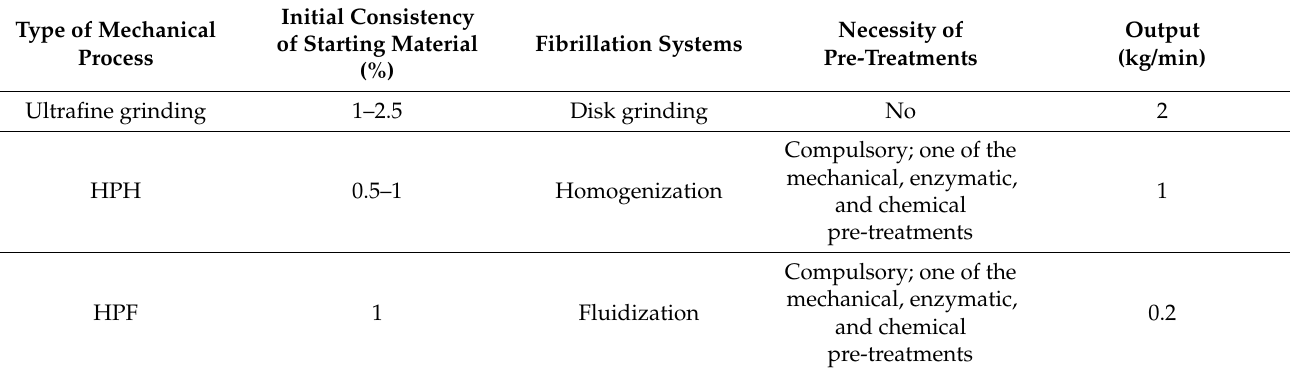
Table 3. The processing conditions of the mechanical approaches for the preparation of CNFs. Type of